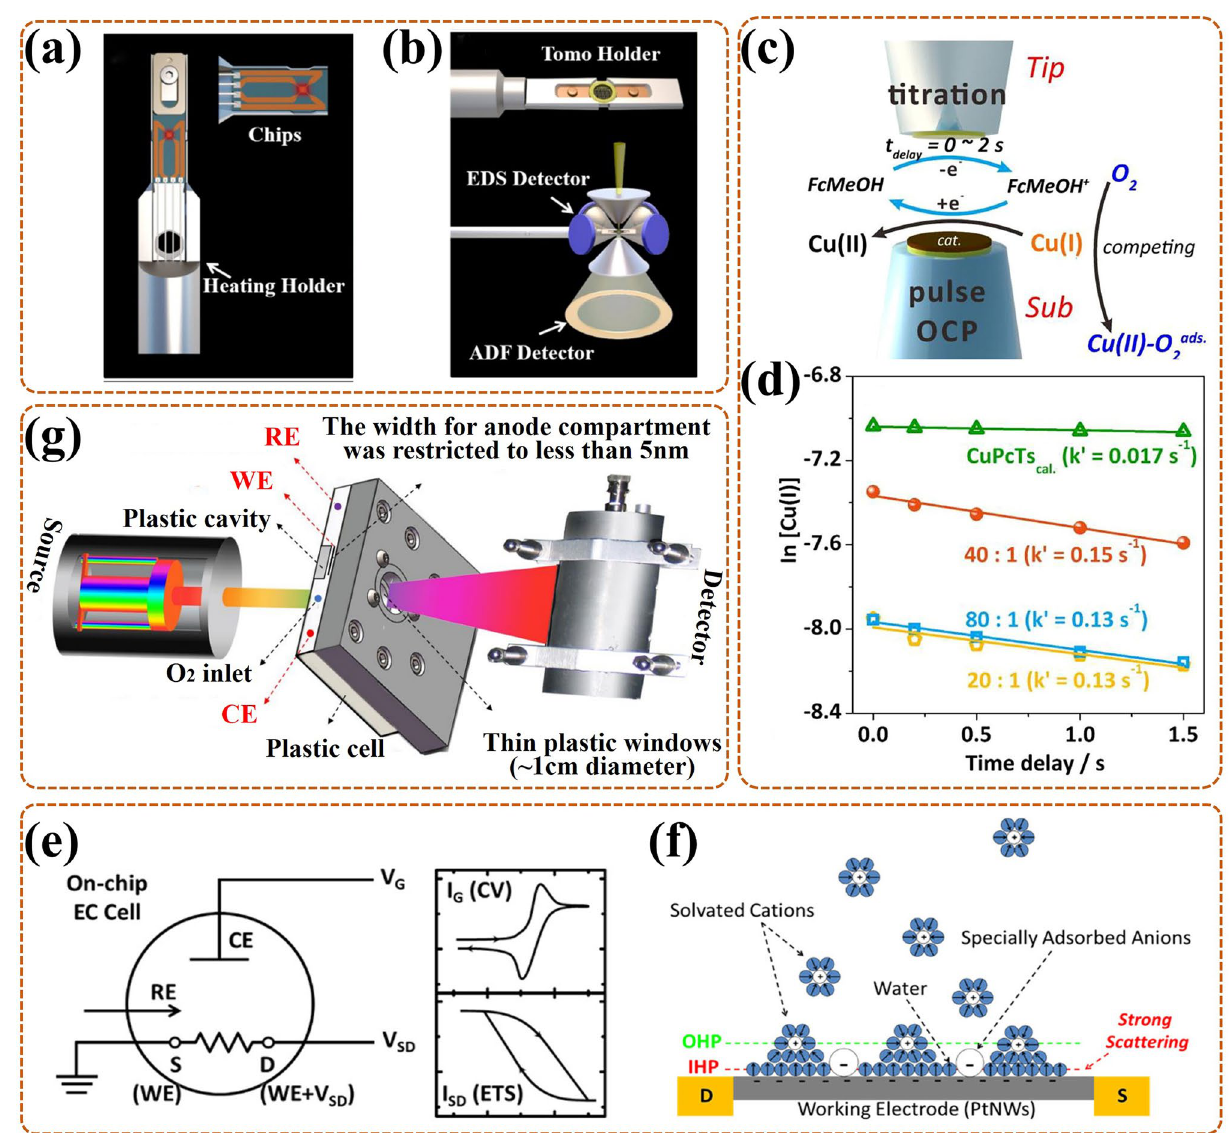
Fig. 4 Elementary diagram of the in-situ TEM cell: a special heating holder and chip, b electron tomography, with HAADF and EDX detectors for collecting 2D HAADF and elemental allocation images at diverse orientations by rotating the holder [96]; Reused with approval; Copyright 2021 Elsevier Ltd. c Schematic diagram of in-situ SI-SECM cell and relevant titration mechanism (with OCP as open circuit potential); d The kinetic rate reflected by ln [Cu( I )]) against t delay ; Reused with approval [101]; Copyright 2020 Elsevier Ltd. e The working principle diagram of ETS and CV at the same time in a three-electrode system (with CE, RE, WE) (S, source; D, drain); f The schematic diagram of in-situ ETS cell, with PtNWs electrode and aqueous electrolyte, with anions adsorbed on the IHP [103]; Reused with approval; Copyright 2018 American Chemi- cal Society. g The illustration of in-situ 57 Fe Mössbauer cell for in-situ testing Fe active site during ORR [109]; Reused with approval;